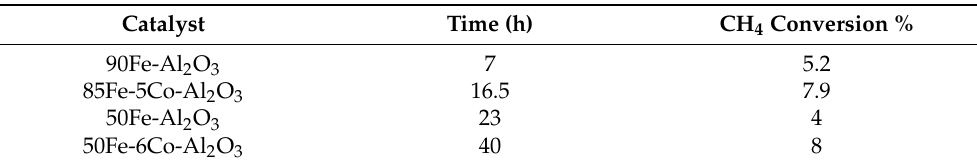
Table 6. Comparison between the monometallic Fe and bimetallic Fe-Co catalysts prepared using the coprecipitation method and tested at 625 ◦ C and 1 atm